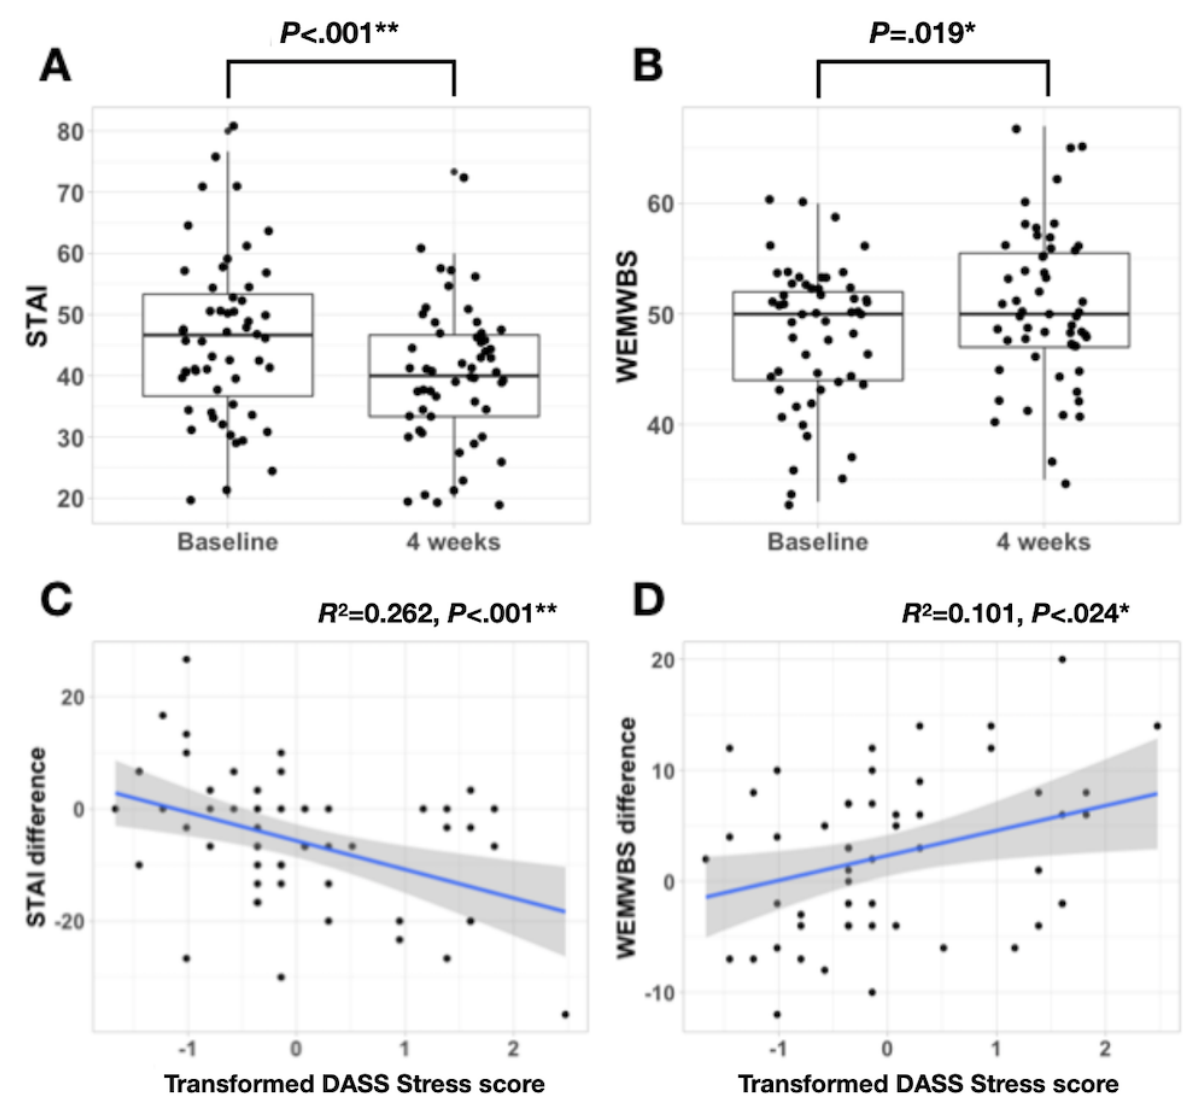
Figure 1. After controlling for paid status, differences in (A) 6-item STAI and (B) WEMWBS after 4 weeks of the BioBase program. Association between transformed DASS Stress scores and difference in (C) STAI and (D) WEMWBS, ** P <.01, * P <.05. DASS: Depression Anxiety Stress